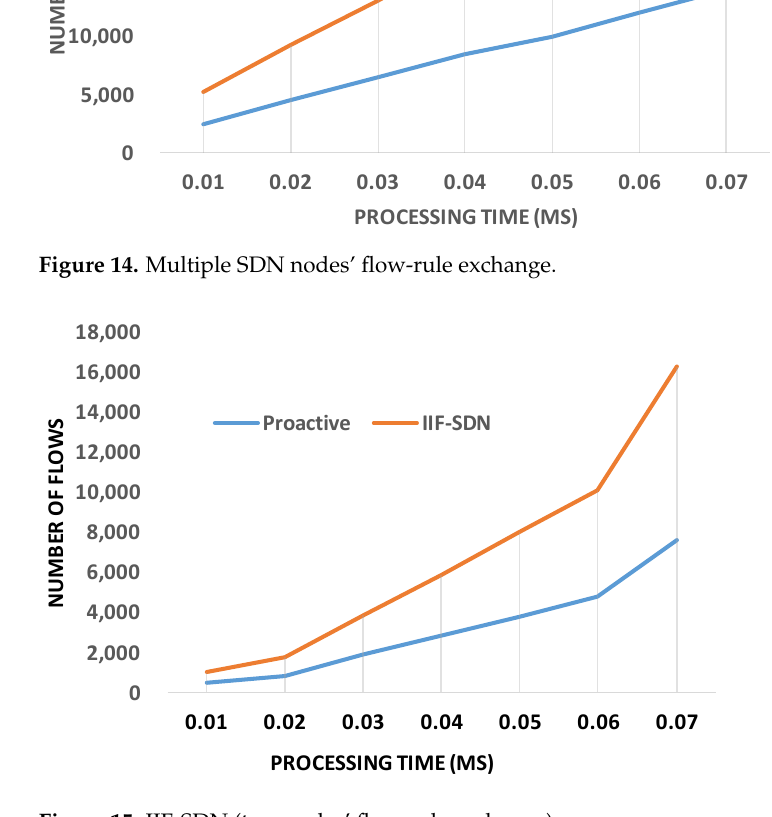
Figure 15. IIF-SDN (two nodes’ flow-rule exchange).